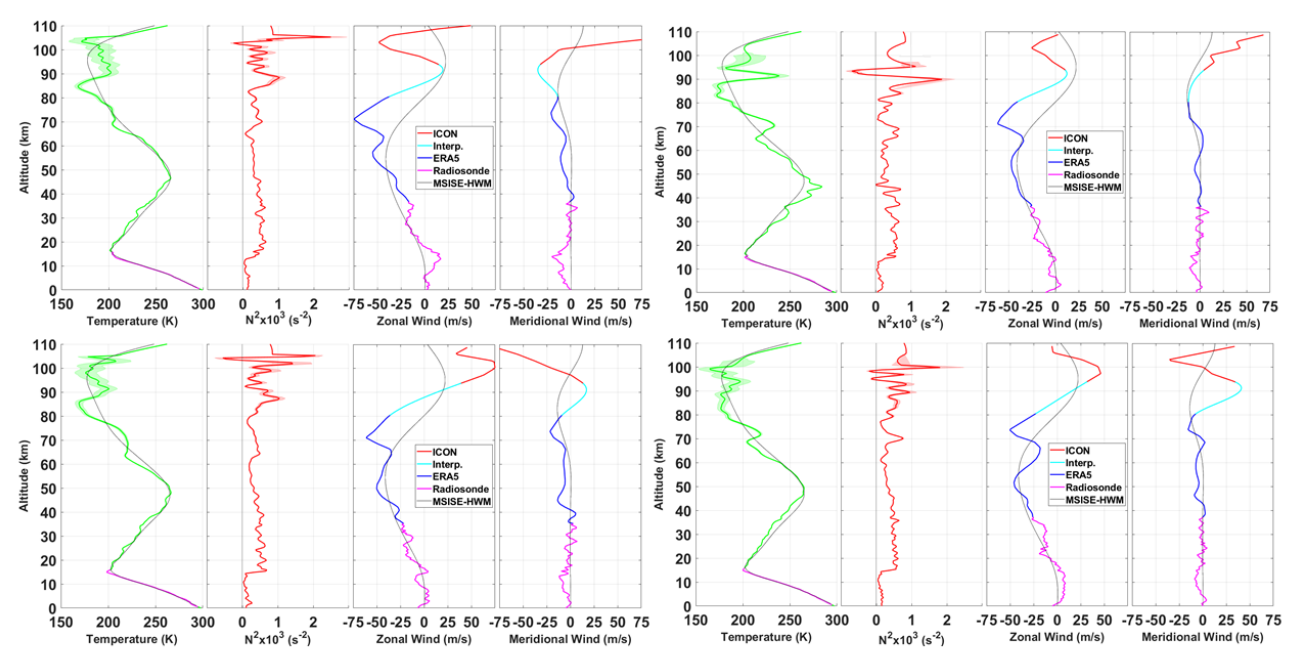
Figure 7. Profiles of merged temperature (green), Brunt–Väisälä frequency (orange), estimated composite zonal wind, and estimated composite meridional wind (magenta, blue, cyan, and red) for D-3 (upper left), D-1 (upper right), D+0 (lower left), and D+1 (lower